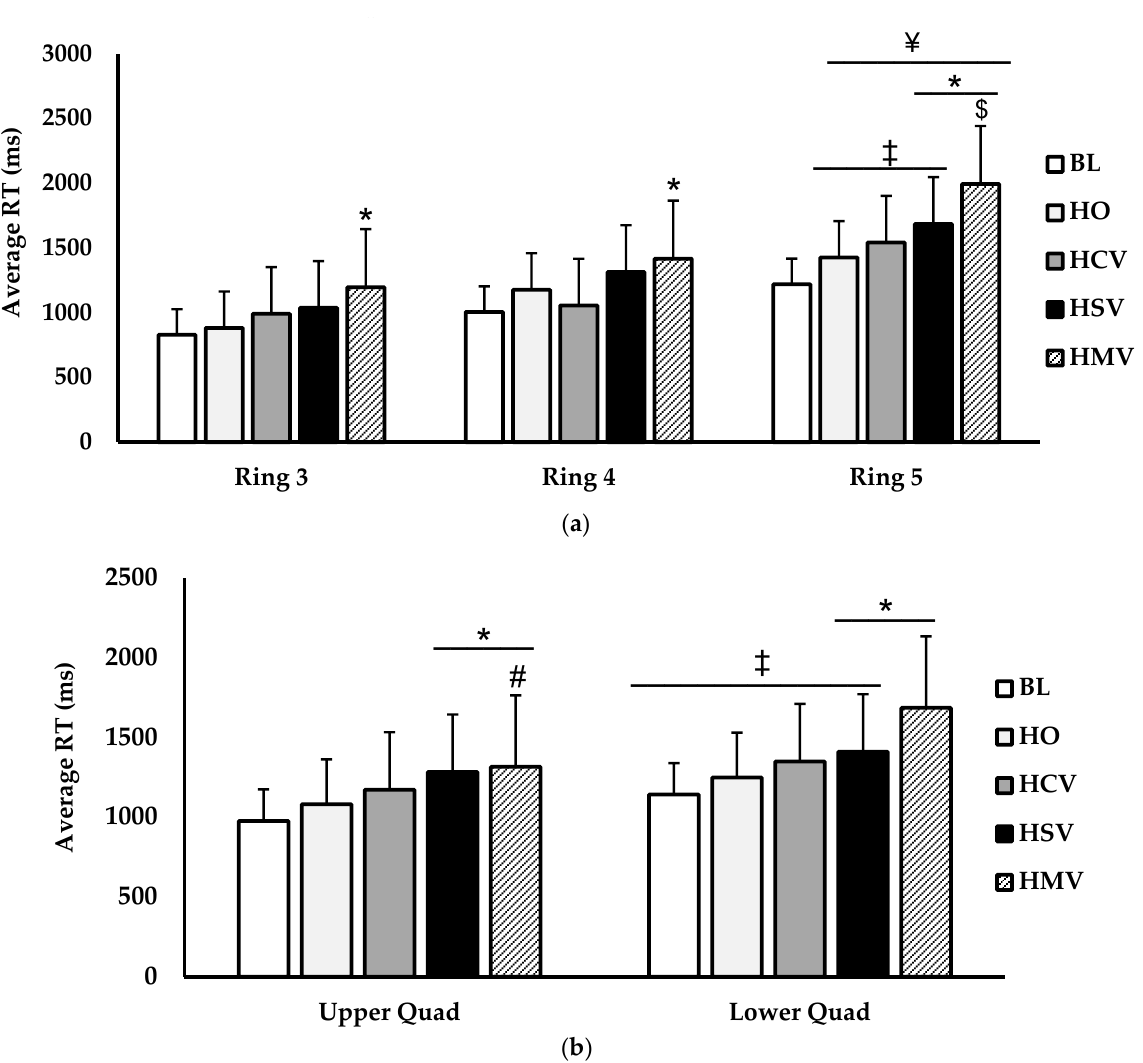
Figure 6. Comparison of ( a ) reaction time (ms) separated by rings (ring 3, ring 4, ring 5), ( b ) reaction time (ms) separated by upper and lower quadrants between baseline (BL; white), helmet only (H); light grey), helmet + clear visor (HCV; grey), helmet + smoke-tinted visor (HSV; black), and helmet + mirror-tinted visor (HMV; black striped) conditions. Data are presented as mean ± SD. * indicates significant difference from baseline ( p < 0.05). # indicates significant difference from HO ( p < 0.05). ‡ indicates significant difference from HMV ( p < 0.05). ¥ indicates significant difference from ring 3 ( p < 0.05). $ indicates significant difference from ring 4 ( p < 0.05).